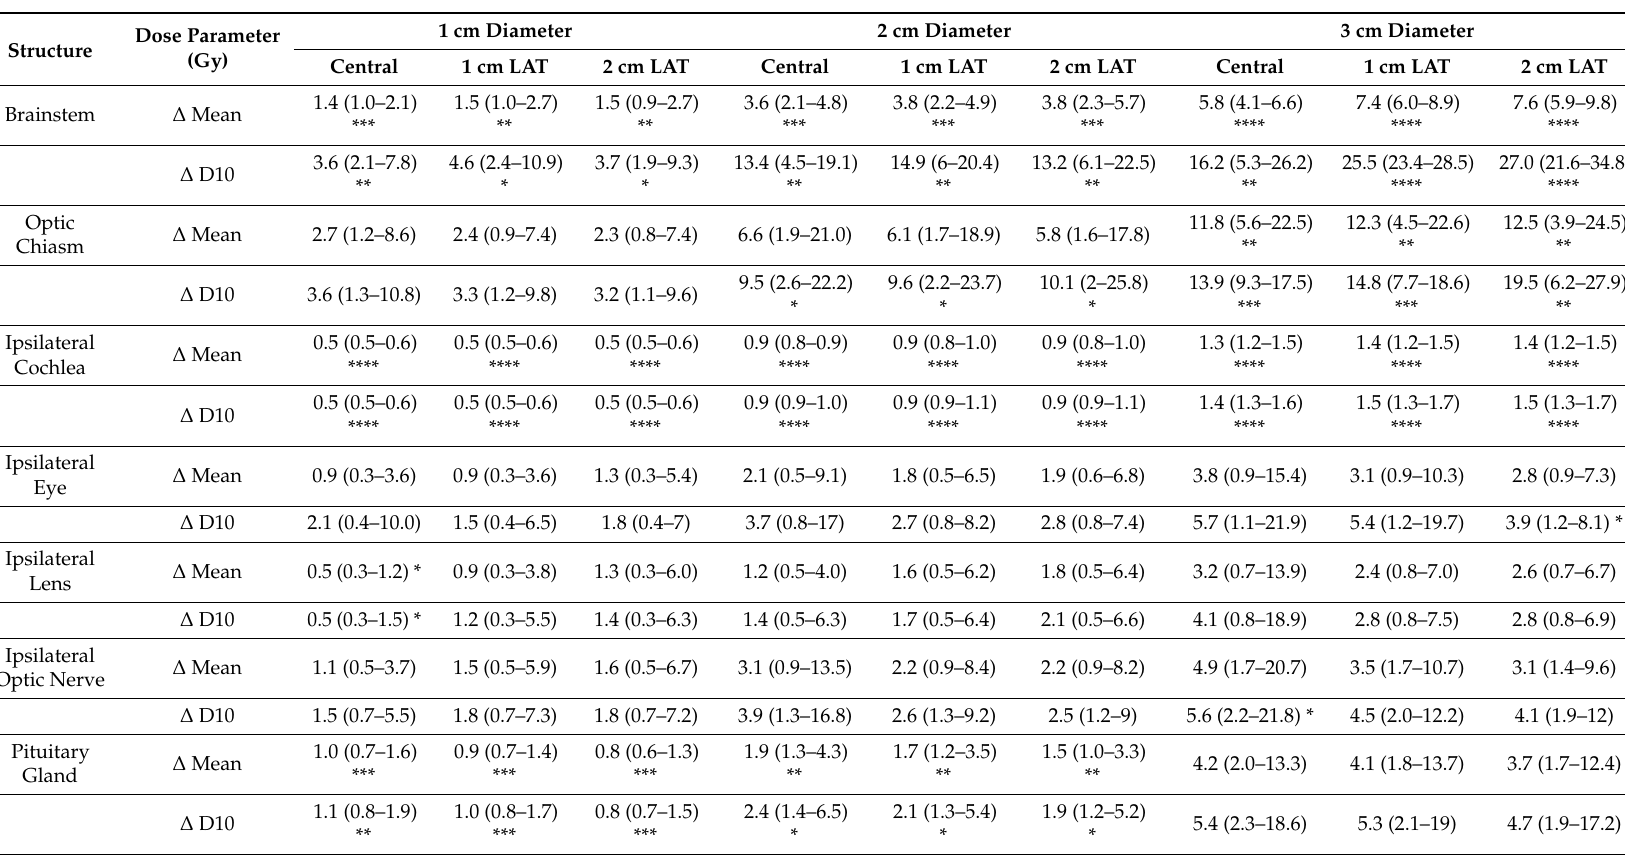
Table 3. Comparison of mean and D10 dose di ff erence ( ∆ IMRT (Gy)-IMPT (Gy(RBE))) for critical structures averaged across 6 patient plans collected for supratentorial ependymoma (prescribed dose 54 Gy /